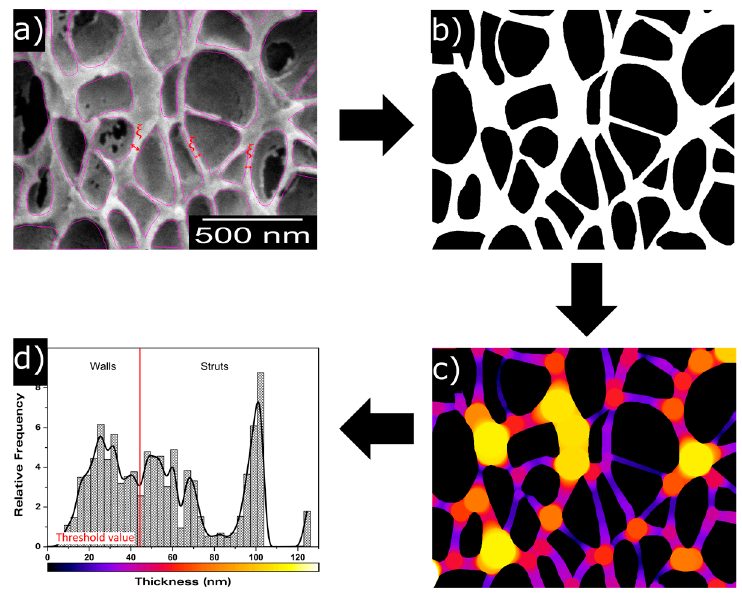
Figure 1. Description of the method to measure the fraction of mass in the struts ( f s ). ( a ) cell mask; ( b ) binarized cell mask; ( c ) local thickness cell image; ( d ) local thickness histogram.